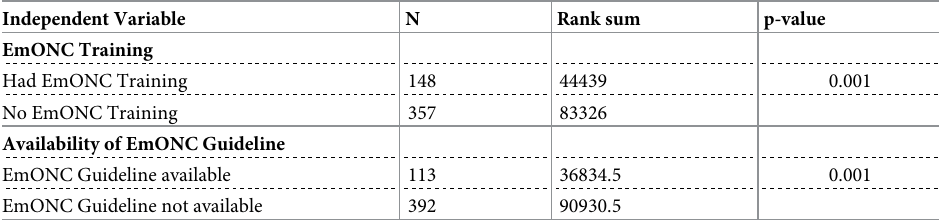
Table 7. Difference in EmONC integration by EmONC training and guideline availability.